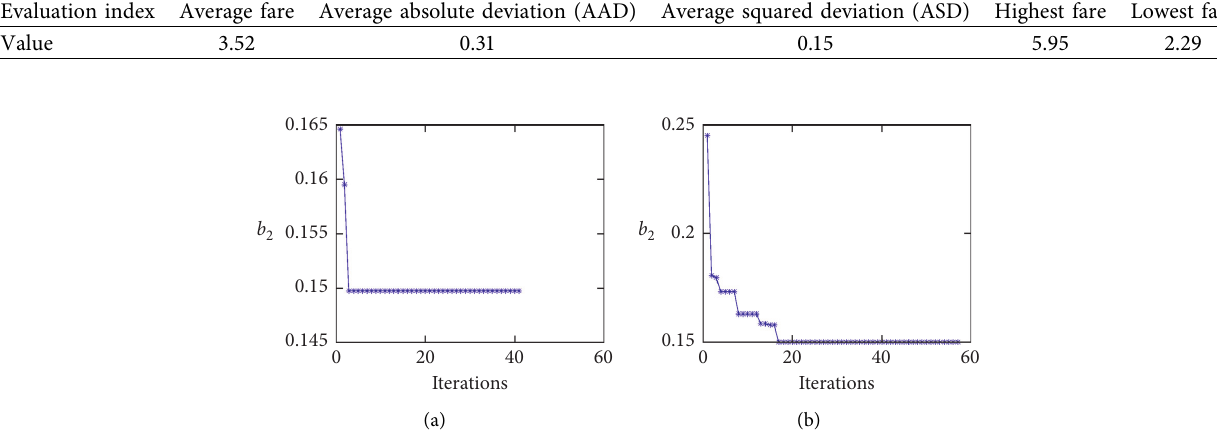
under PKM. (b) The value of b 2